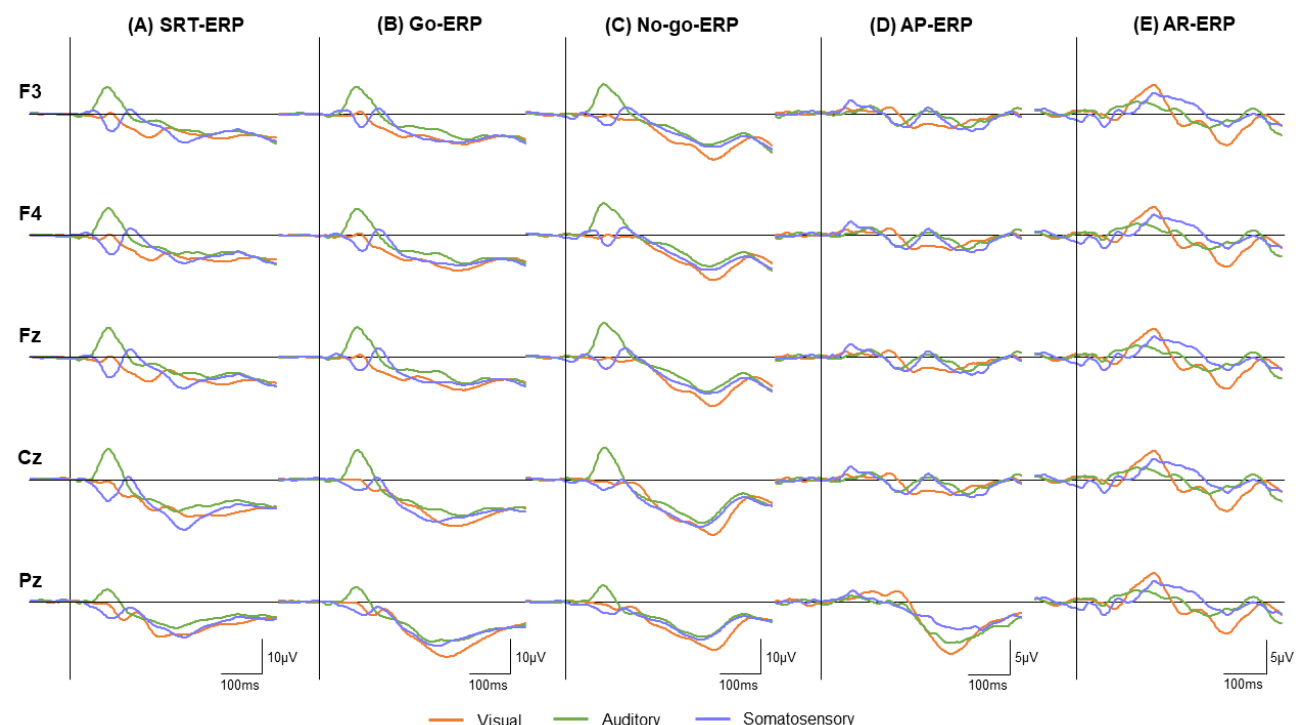
Figure 5. Grand-averaged SRT-, Go-, No-go-, AP-, and AR-ERP in each modality. The orange, green, and blue lines represent the visual, auditory, and somatosensory modalities, respectively. Each column shows ( A ) signal-locked ERP in the SRT, ( B ) Go signal-locked ERP in the GNT, and ( C ) No-go-signal-locked ERP in the GNT at five electrodes. ( D ) the AP-ERP, which calculates the waveform difference by subtracting the SRT-ERP from Go-ERP. ( E ) the AR-ERP, which calculates the waveform difference by subtracting the Go-ERP from No-go-ERP at each electrode. The present study obtained main significance findings that the AP-N2 latency at F3, F4, and Fz was significantly shorter in the visual modality than in the auditory ( p = 0.003) and somatosensory modalities ( p = 0.001) ( D ). Additionally, the AR-N2 amplitude at F4 was larger in the visual modality than in the auditory modality ( p = 0.036) and the P3 latency at Cz was longer in the visual modality than in the auditory modality ( p = 0.042) ( E ). AP, action postponing; AR, action restraint; SRT, simple reaction task; ERP, event-related potential; SRT-ERP, signal-locked waveforms in SRT; Go-ERP, Go signal-locked waveforms; No-go-ERP, No-go-signal-locked waveforms.